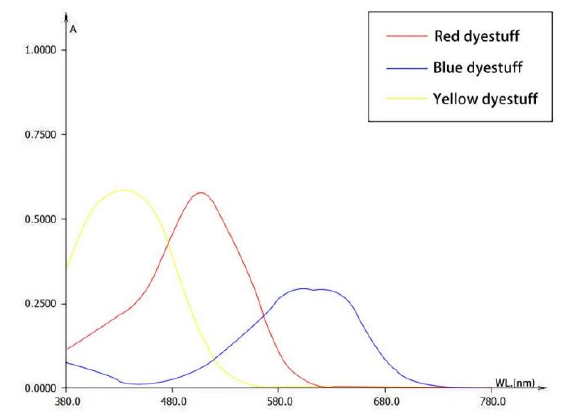
Figure 3. Measurement points.